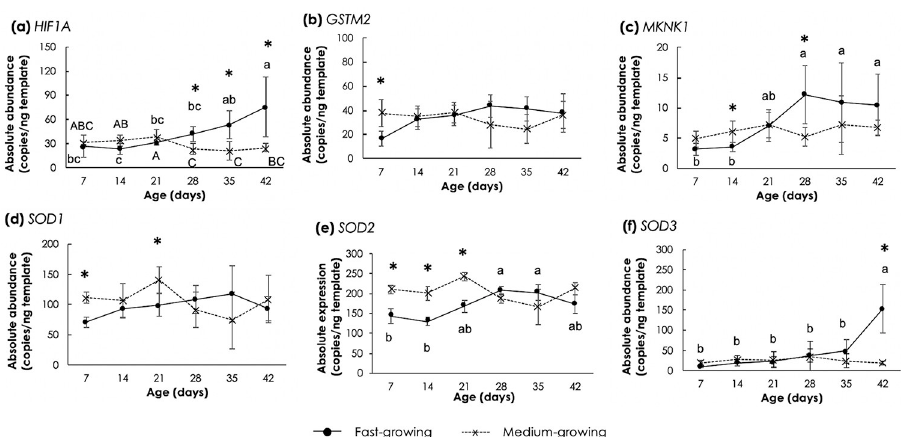
Fig 2. Absolute transcript abundance of genes responsible for hypoxia and oxidative stress response in Pectoralis major muscle of fast- and medium-growing chickens at different ages. The genes include (a) hypoxia-inducible factor 1 A ( HIF1A ), (b) glutathione S-transferase mu 2 ( GSTM2 ), (c) mitogen-activated protein (MAP) kinase interacting serine/threonine kinase 1 ( MKNK1 ), (d) cytosolic superoxide dismutase 1 ( SOD1 ), (e) mitochondrial superoxide dismutase 2 ( SOD2 ), and (f) extracellular superoxide dismutase 3 ( SOD3 ). Markers and error bars depict mean and standard deviation (n = 5). Lower case letters indicate significant differences among fast-growing chickens. Upper case letters indicate significant differences among medium-growing chickens. Asterisks indicate significant differences between the two chicken strains at the same age. � p < 0.05, �� p < 0.01, ��� p < 0.0001.